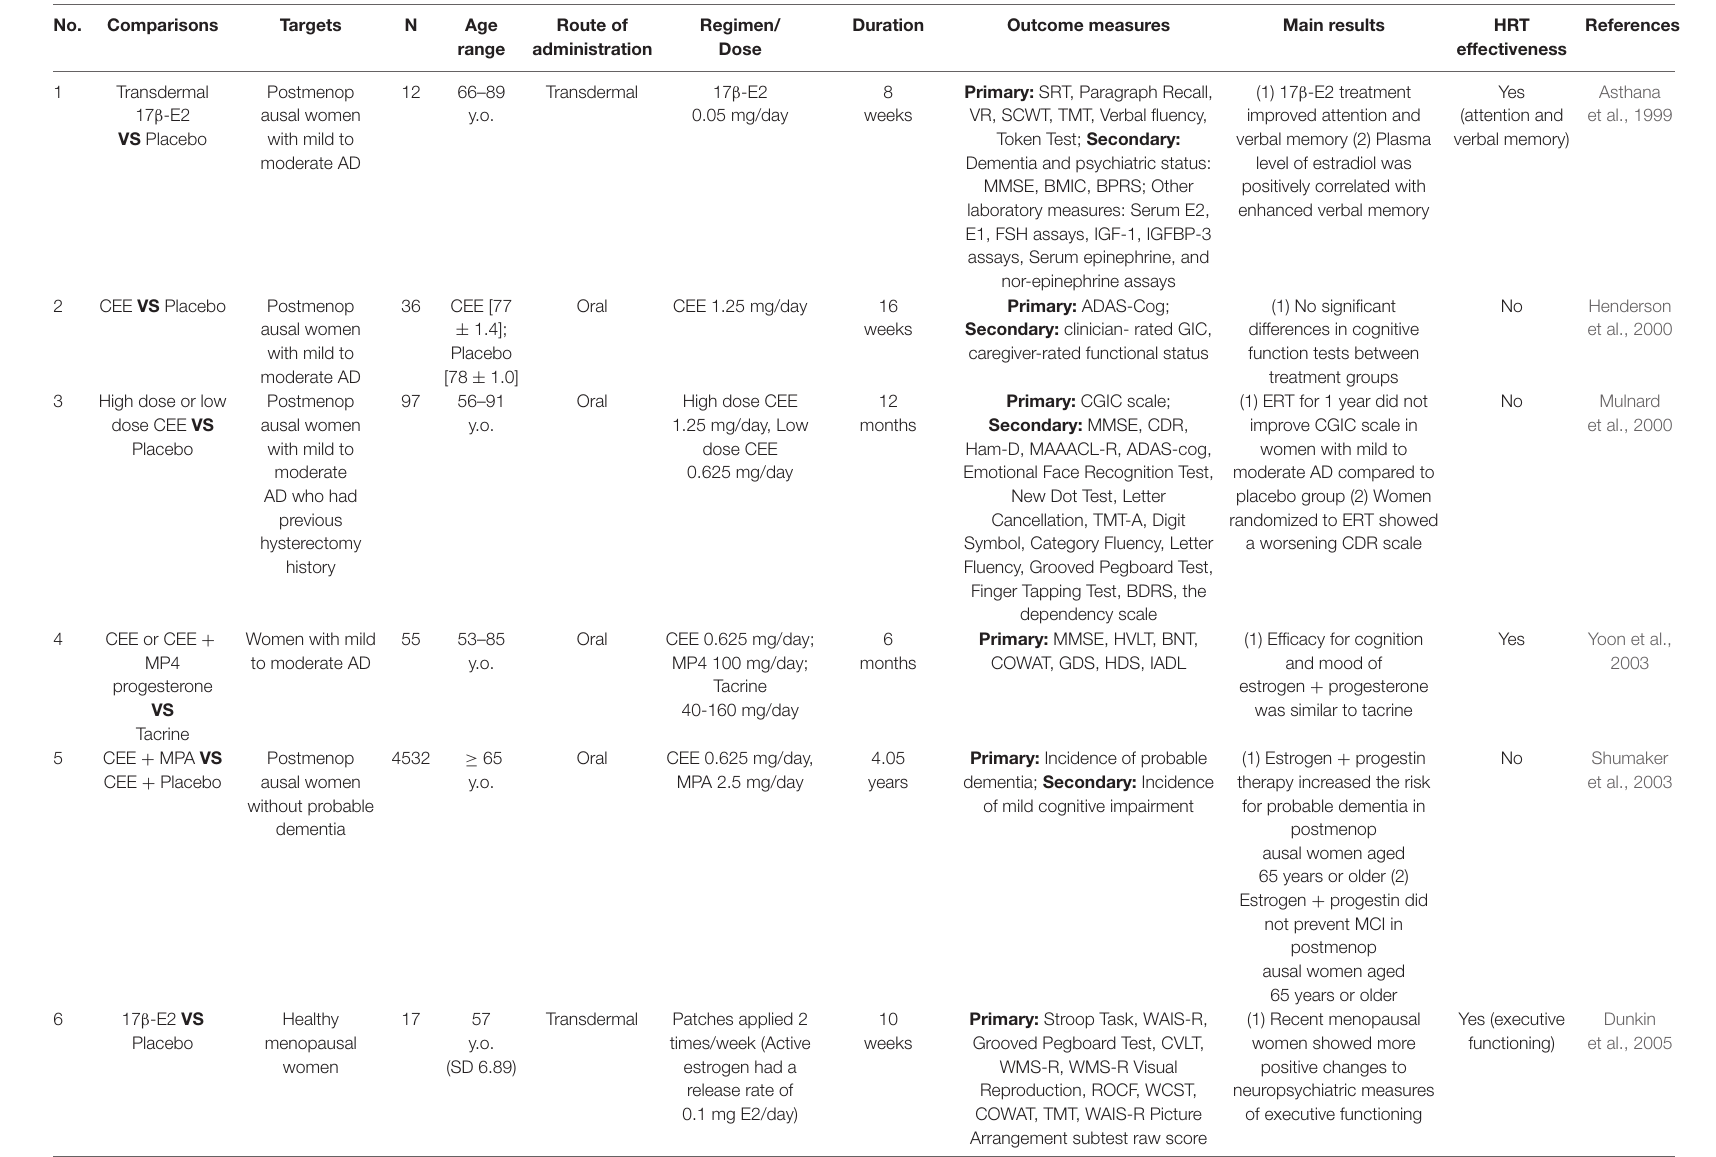
TABLE 1 | Summary of selected randomized clinical trials (RCTs) of the hormone replacement therapy (HRT) effects on cognitive function among postmenopausal women of AD or non-AD group.